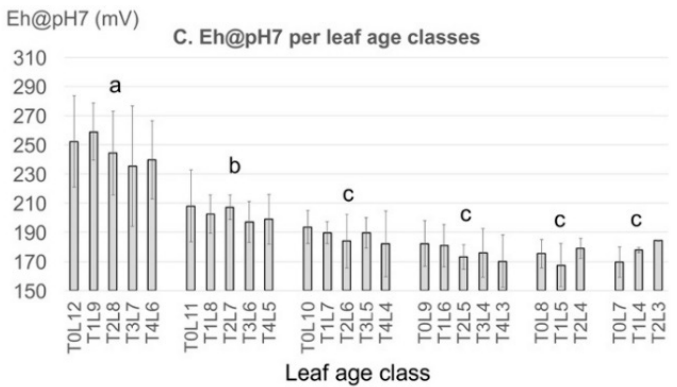
Figure 6. Inter-leaf variability of Eh ( A ), pH ( B ) and Eh@pH7 ( C ) respectively and pairwise comparisons between six age groups. Data are means of the middle part of the leaf of four 61 to 64-day-old plants from season II, sown 17 August 2016 under upland management. Age groups with different letters are significantly different at 95% confidence interval (REGW- Q test).